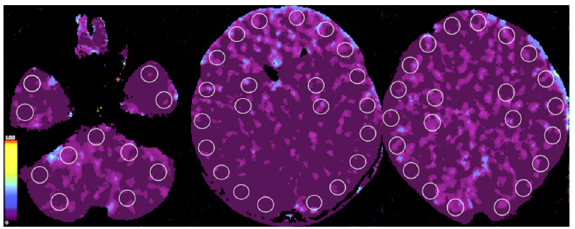
Figure 2. Criteria of CCA in CTP imaging. Axial sections of brain with marked positions of ROIs. Color scale illustrates range of CBF (mL/100 g/min). CBF < 10 mL/100 g/min confirms CCA.